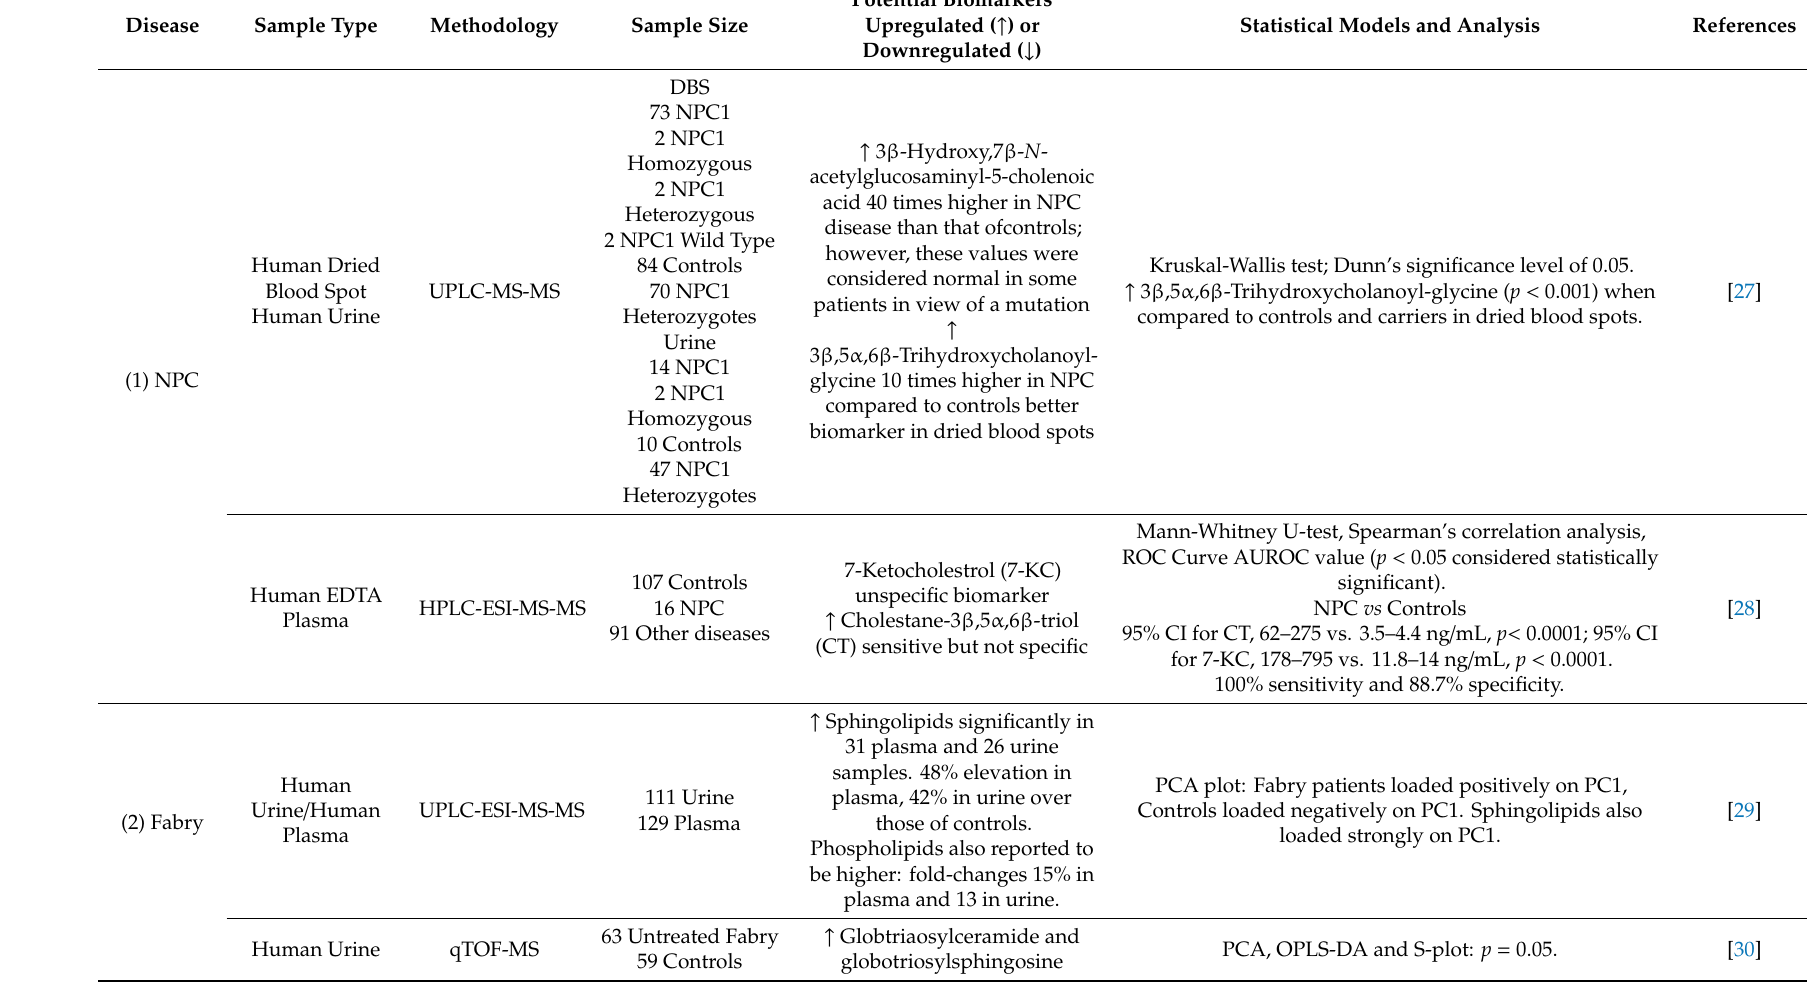
PCA plot: Fabry patients loaded positively on PC1, Controls loaded negatively on PC1. Sphingolipids also loaded strongly on